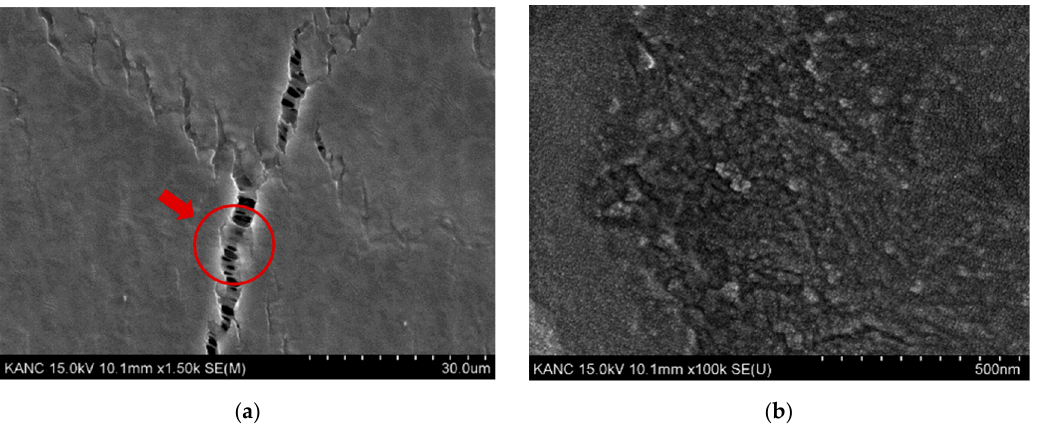
Figure 4. SEM image of transferred PANI film: ( a ) the island-bridge structure; ( b ) enlarged image of PANI film.